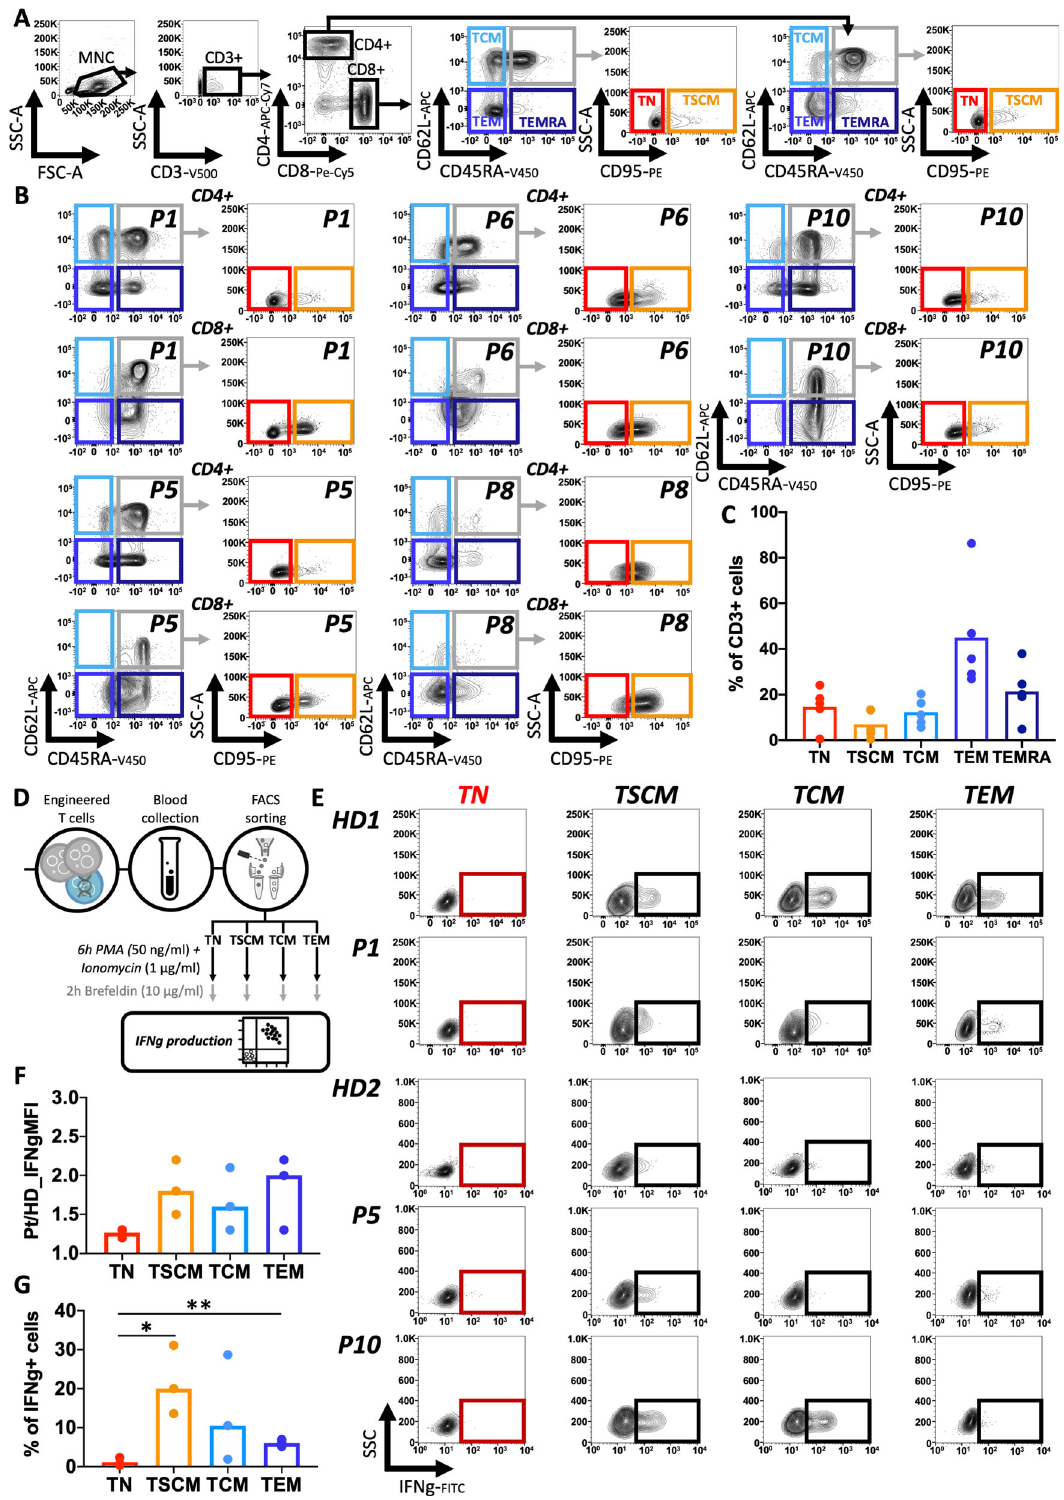
Fig. 2 Immunophenotypic and functional validation for the identi fi cation of naïve T cells. A Gating strategy used for identifying naïve T cells (TN), T memory stem cells (TSCM), T central memory (TCM), T effector memory (TEM) and T effector memory CD45RA + (TEMRA) subpopulations inside the CD4 + or CD8 + T cells (data displayed are from a healthy donor used as reference). B FACS plot showing CD4 + and CD8 + T cell composition at the latest follow up for each patient. C Percentage of TN, TSCM, TCM, TEM and TEMRA inside the CD3 + population at latest follow up in the fi ve patients analysed. D Experimental scheme for Interferon gamma (IFNg) production assay on four sorted T cell subpopulations. E FACS plot showing IFNg expression after PMA/ Ionomycin stimulation in each sorted subpopulation from two healthy donors (HD1 and HD2) and three patients (P1, P5 and P10). F Ratio between IFNg mean fl uorescence intensity (MFI) measured in patients vs. healthy donors T-cell subtypes after stimulation. G Percentage of IFNg-positive cells measured in each T-cell subtype from patients after stimulation (unpaired two-tailed t -test * p < 0.05 [TN vs. TSCM p = 0.0165], ** p < 0.01[TN vs. TEM p = 0.0033]). NATURE COMMUNICATIONS| (2021) 12:1622 |https://doi.org/10.1038/s41467-021-21834-9|www.nature.com/naturecommunications